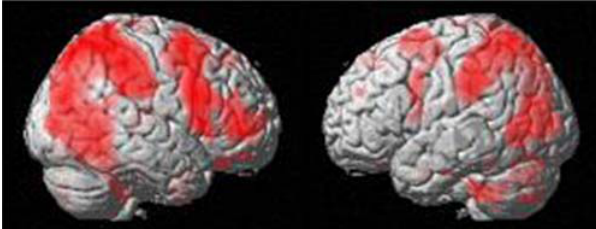
Figure 4. Areas showing a significantly higher activation for decision on action observation (‘‘is the hand holding the object with all five fingers?’’) than for conceptual or phonological tasks involving the same video stimuli (Vd-Perc . (Vd-Phon + Vd-Conc)). Comparison with the bilateral network for action observation (Fig. 3a) revealed that most the bilateral parietal and right frontal activations were activated when an action observation-related task was done but not if a concurrent cognitive task of conceptual or phonological decision on the same stimuli were performed.